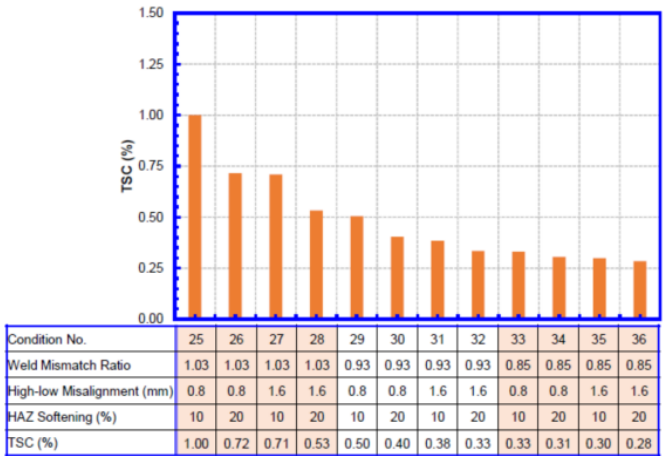
Figure 10. TSC of girth welds with 12.8 mm + 12.8 mm WT.